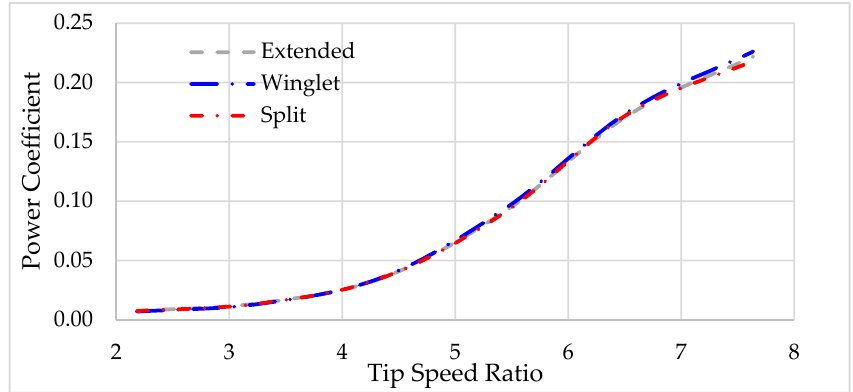
Figure 6. Tip speed ratio sweep at V = 11 m/s.